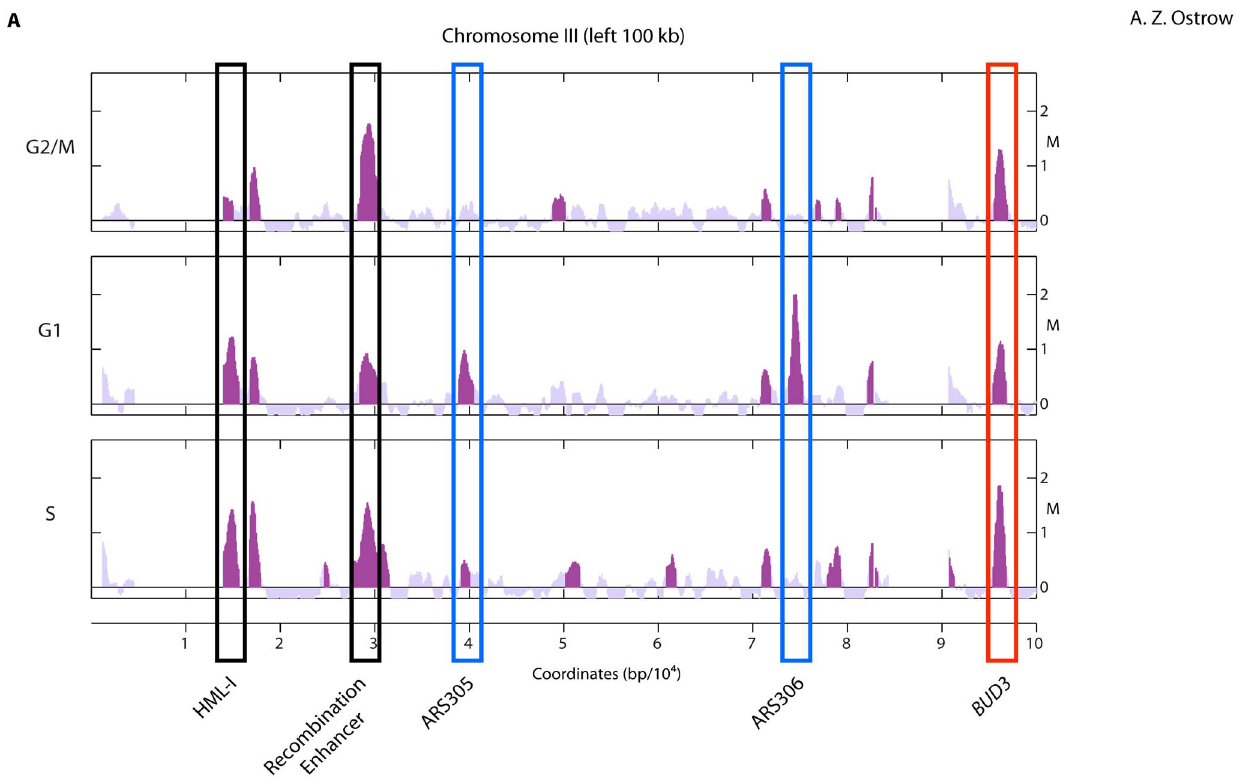
Figure 8. G1-specific binding of Fkh1/2 at Fkh-activated origins. Plots show averaged ChIP-chip signal from three experimental replicates along a 100 kb region of the left arm of chromosome III, with enriched regions plotted in purple. The cell cycle arrest for each experiment is indicated to the left of each panel. Boxed loci are discussed in the Results .